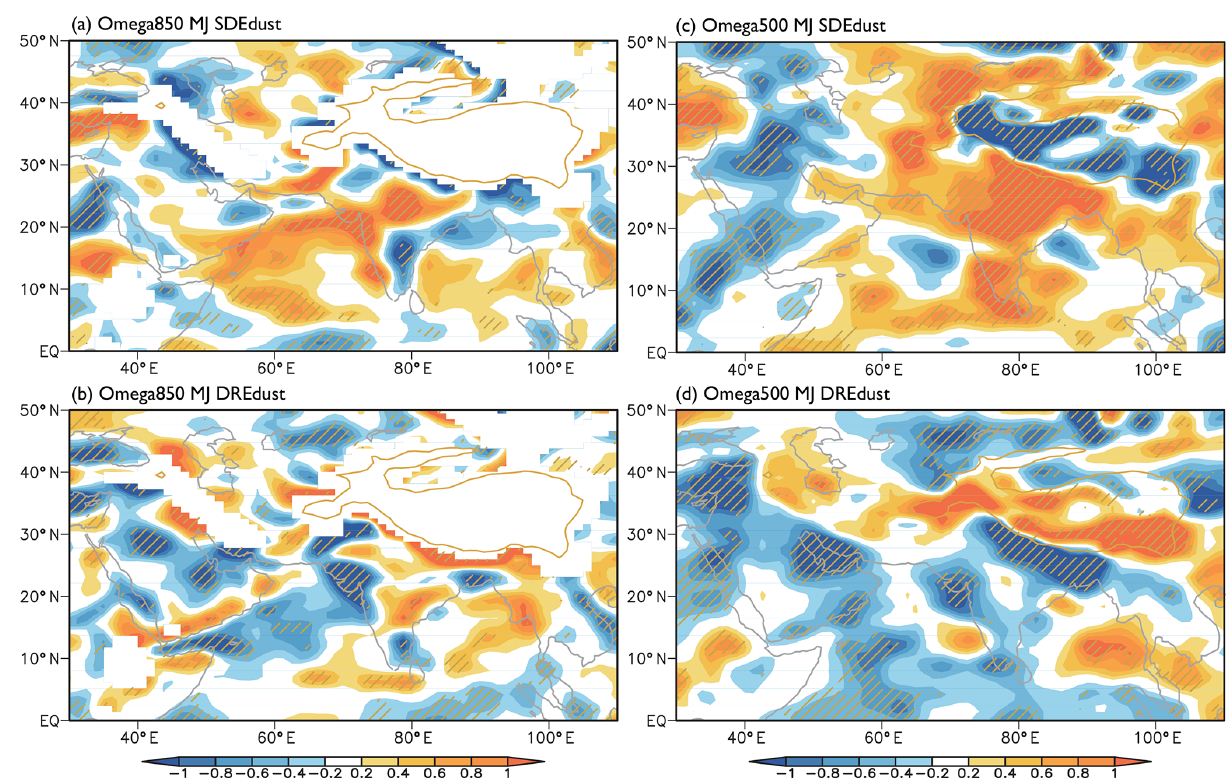
Figure 8. Spatial distribution of changes in 850 (a, b) and 500hPa (c, d) vertical wind speed ( × 100, Pas − 1 ) in May and June induced by the snow-darkening effect (a, c) and direct radiative effect of dust (b, d) , respectively. Negative values indicate upward flow and positive values indicate downward flow. Oblique lines indicate differences significant at the 95% confidence level. Yellow line shows the profile of the Tibetan Plateau above